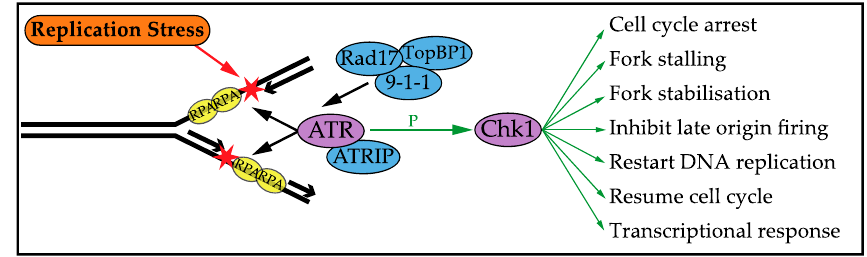
Figure 1. DNA replication stress is the slowing down or stalling of replication forks, which exposes single ‐ stranded DNA (ssDNA). ssDNA is bound by Replication Protein A (RPA), which recruits proteins to the stalled fork (recruitment shown with black arrows). This activates the sensor kinase Ataxia Telangiectasia and Rad3 ‐ related protein (ATR), which phosphorylates and activates the effector kinase Chk1. Chk1 phosphorylates a wide range of targets in the cell to carry out the DNA replication stress checkpoint functions shown.